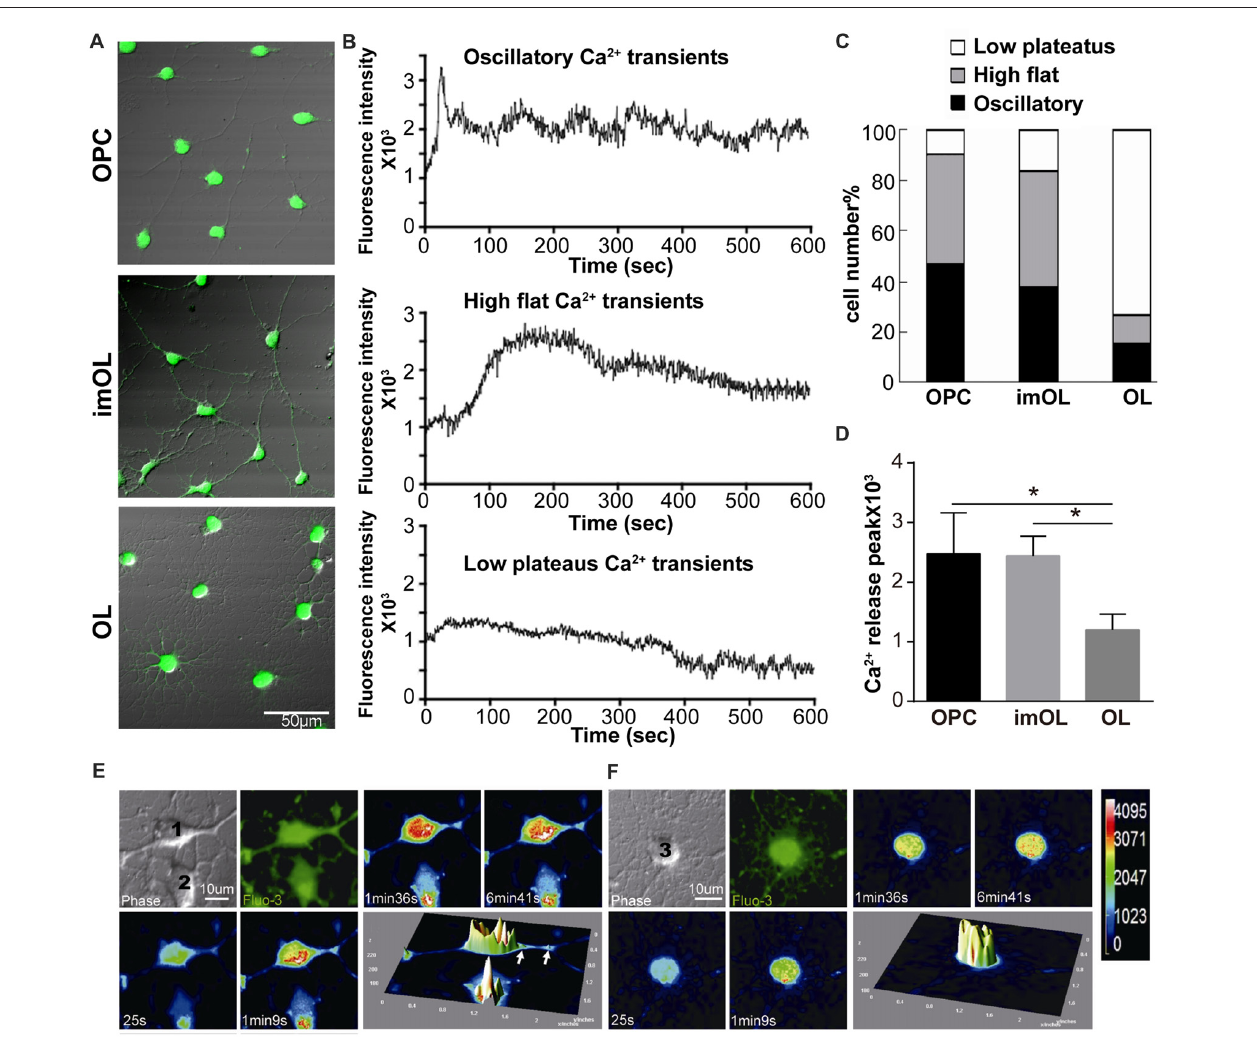
FIGURE 2 | Endoplasmic reticulum (ER) Ca 2 + release following caffeine stimulation is stage specific during OPC differentiation. (A) Differential interference contrast (DIC) with Fluo-3 fluorescence of three stages of OL lineage cells, showing typical shape of OPC, imOL and OL. Note that the pictures were acquired at the end point of Ca 2 + imaging to ensure the morphology of the oligodendroglial cells, thus Fluo-3 fluorescence was extremely strong. (B) Representative examples of Ca 2 + response following caffeine stimulation. Note that the start point in the x-axis is not the beginning point of recording, baseline recording is omitted from the curve. (C) OPCs and imOLs, which tend to respond with oscillatory Ca 2 + transients and high flat Ca 2 + transients, reacted stronger than OLs, which tend to respond with low plateaus Ca 2 + transients. (D) OPC and imOL had significantly higher Ca 2 + release peaks after caffeine stimulation compared with mature OLs ( ∗ p <